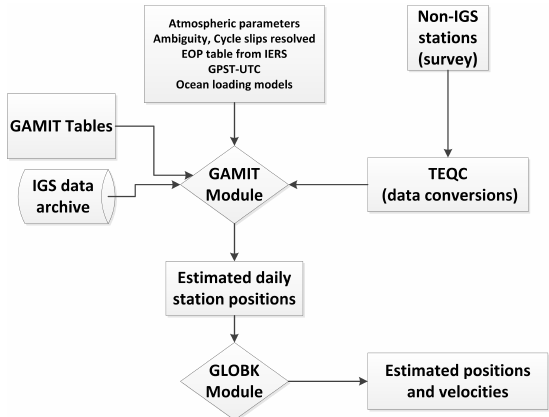
Fig. 3. Simple flow chart of the GAMIT/GLOBK (version 10.4) soft- ware.